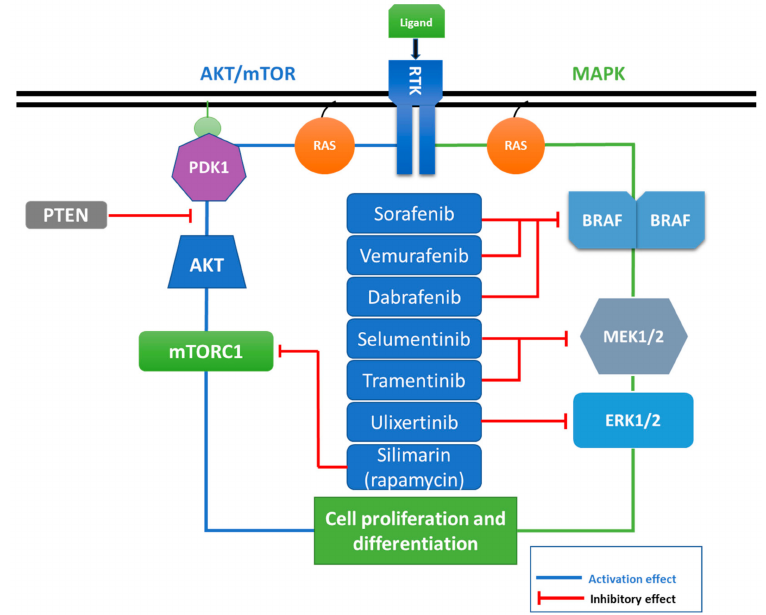
Figure 3. Targeted components of the MAPK and AKT signaling cascades by small-molecule